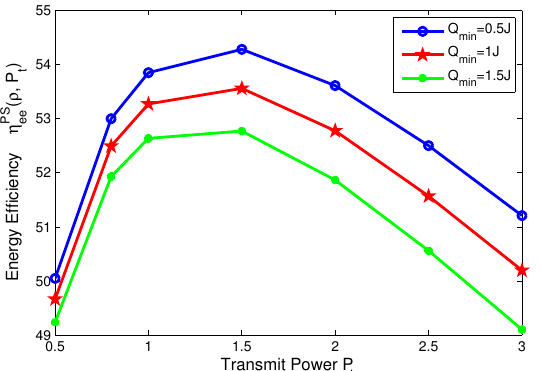
Figure 10. Energy efficiency versus transmit power with different minimum harvested energy requirements for PS